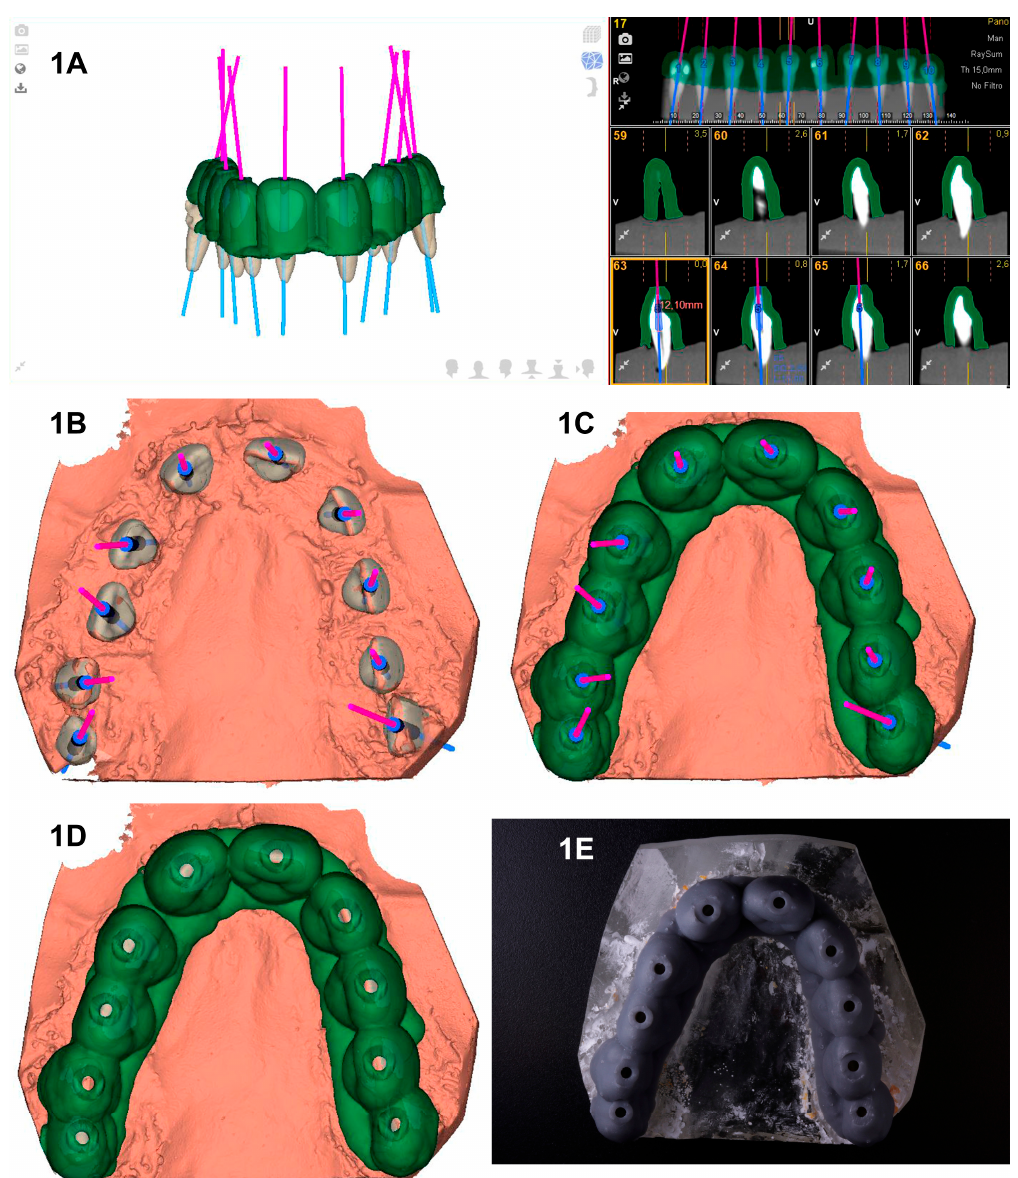
Figure 1. ( A , B ) Endodontic access cavities planned with the computer-aided static navigation system incorporating the cone-beam computed tomography (CBCT) scan (pink lines); ( C , D ) virtual template design according to planned virtual endodontic access cavities; and ( E ) manufactured stereolithography template fixed over dental surface of teeth placed over epoxy resin model.